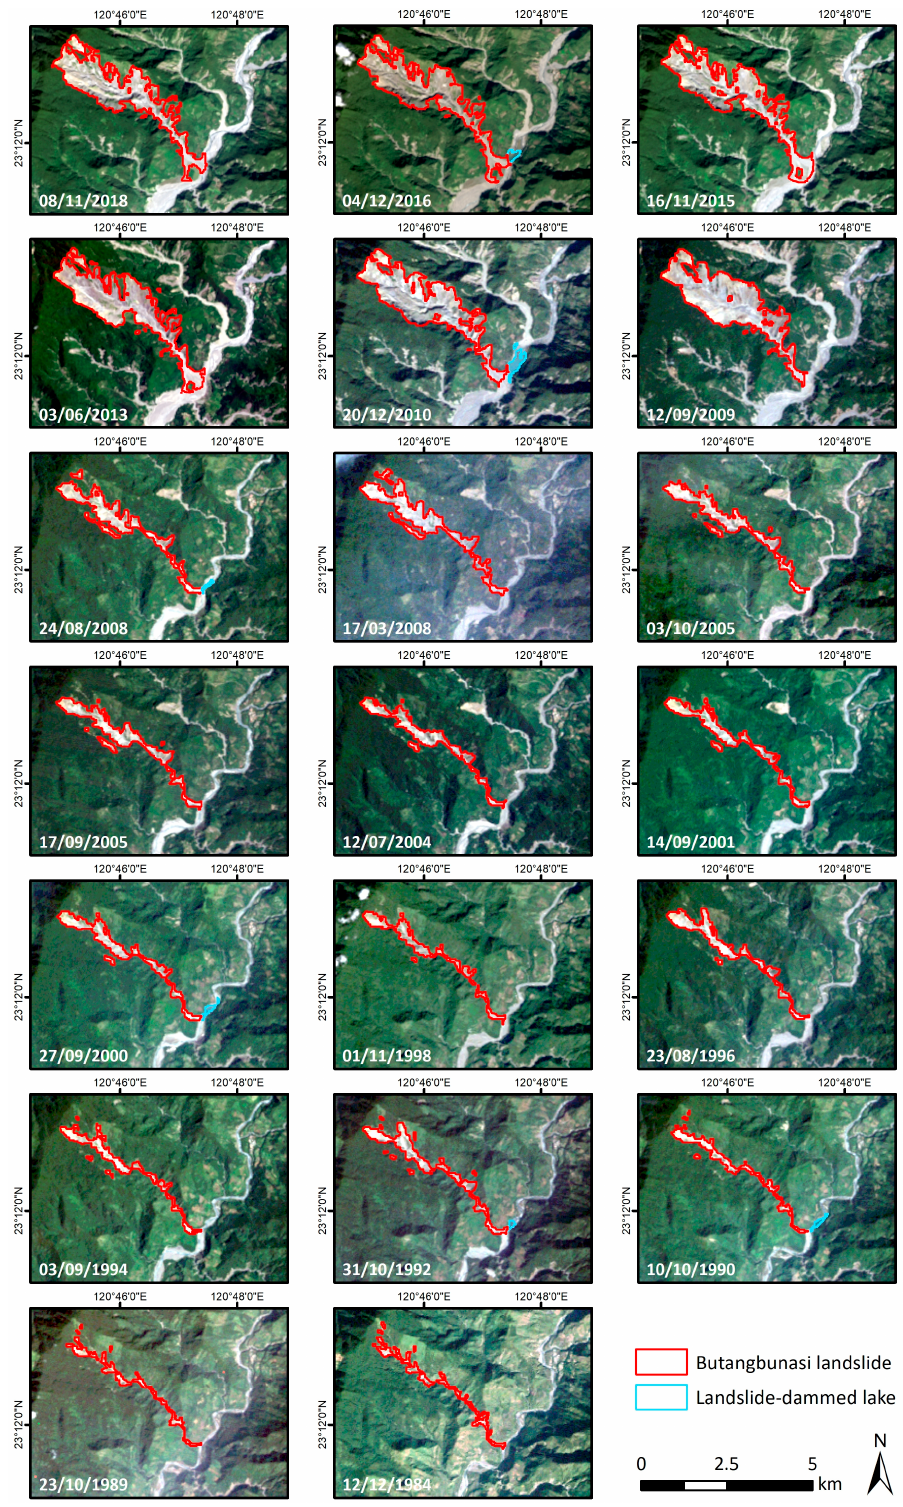
Figure 4. Object-based image analysis (OBIA) landslide mapping results for Butangbunasi. The evolution of the landslide area from 1984 to 2018 is shown per Landsat image. Additionally, a landslide-dammed lake was detected on six of the images (2016, 2010, August 2008, 2000, 1992 and 1990).